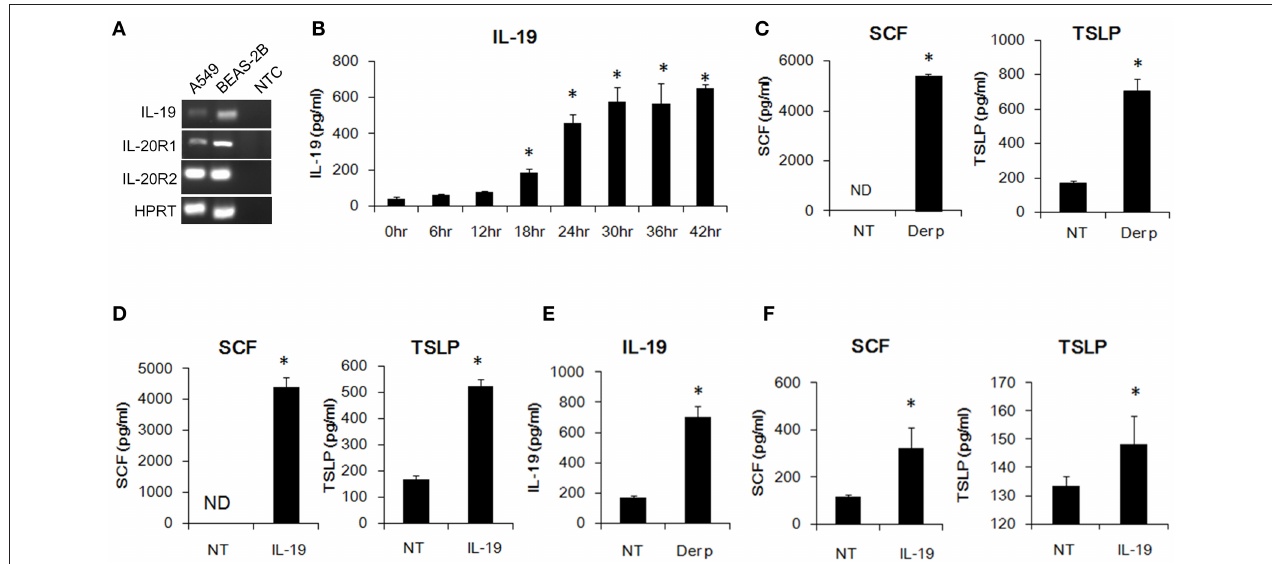
FIGURE 1 | IL-19 was induced by Der p and upregulated SCF and TSLP production in lung epithelial cells in vitro . (A) RT-PCR analysis for the transcripts of IL-19, IL-20R1, and IL-20R2 in A549 and BEAS-2B cells. (B) IL-19 protein levels in the media of Der p (500ng/ml)-treated A549 cells for different time courses. * P < 0.05 by one-way non-parametric ANOVA. (C) Stem cell factor (SCF) and thymic stromal lymphopoietin (TSLP) protein levels in the culture media of A549 cells treated with Der p (500ng/ml) for 24h. (D) A549 cells were treated with IL-19 (200ng/ml) for 24h and the culture media were collected for ELISA analysis of SCF and TSLP levels. (E) IL-19 levels in the culture media from BEAS-2B cells treated with Der p (500ng/ml) for 24h. (F) SCF and TSLP protein levels in the culture medium from BEAS-2B cells treated with IL-19 (200ng/ml) for 24h. NT, no template control; ND, not detectable. * P < 0.05 by t -test.